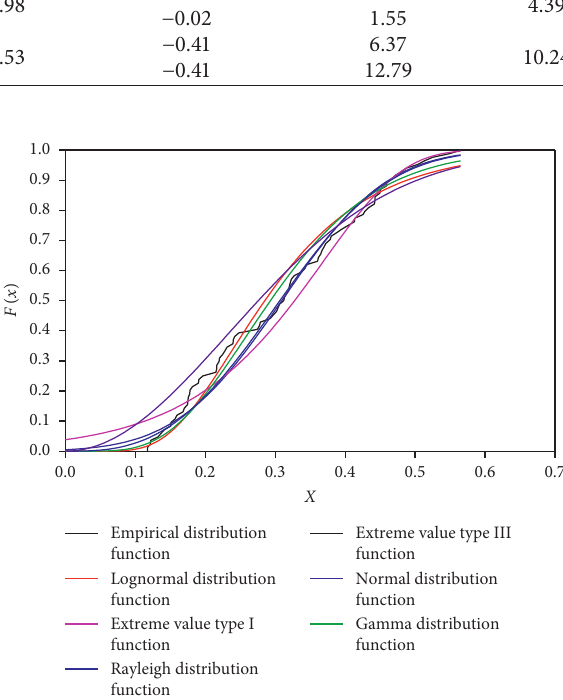
Figure 20: Empirical distribution function along the Z axis and theoretical distribution